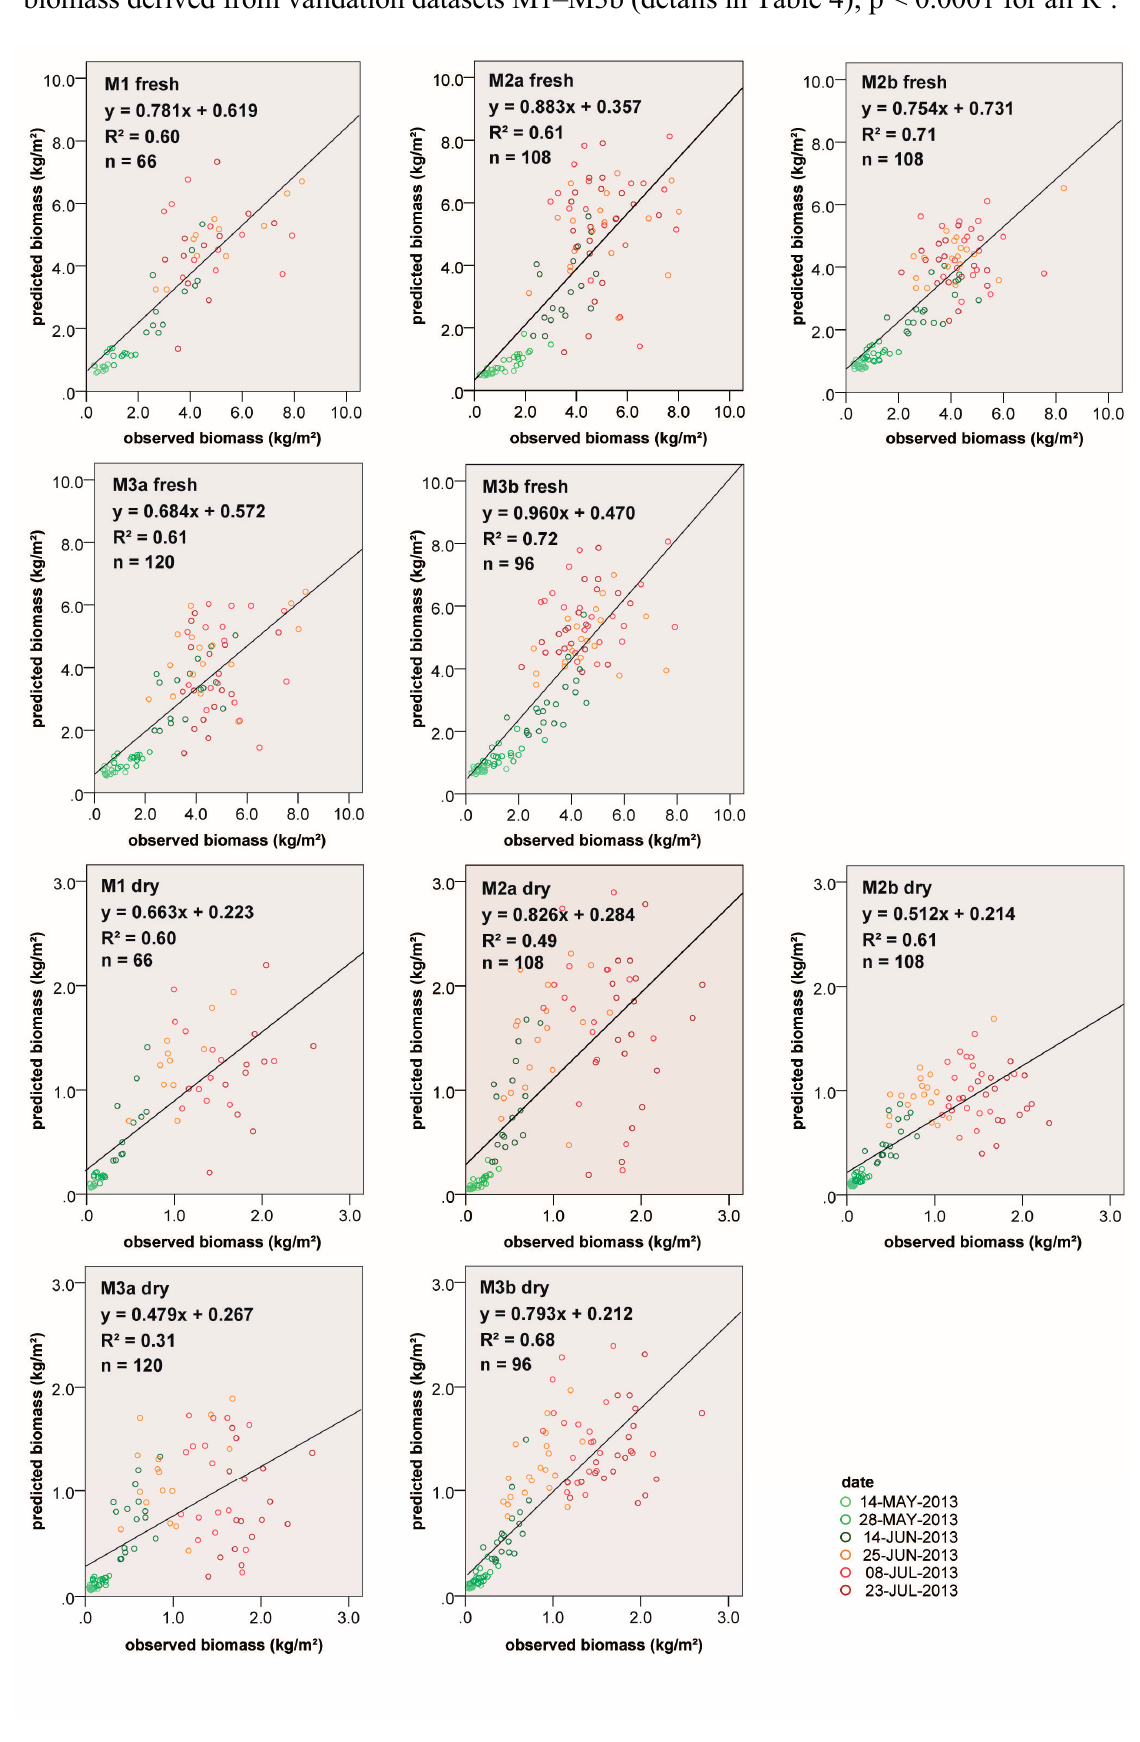
Figure 5. Cross-validation scatter plots for observed fresh and dry biomass versus predicted biomass derived from validation datasets M1–M3b (details in Table 4); p < 0.0001 for all R 2